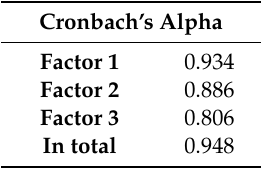
The background color is necessary for distinguishing the variables from the results.